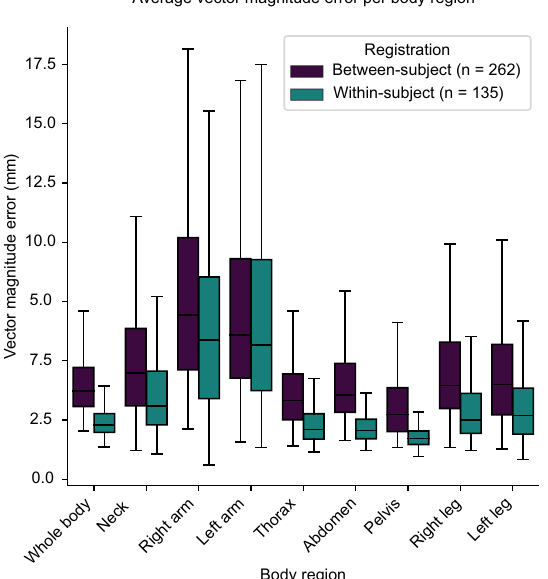
Figure 4. Box plots of average vector magnitude error computed per body region and registration